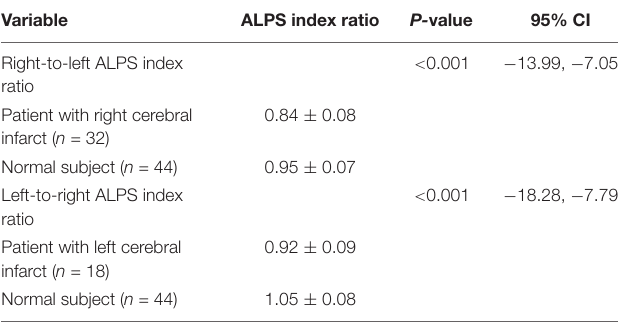
TABLE 2 | Comparisons of right-to-left and left-to-right ALPS index ratios between patients and normal subjects.